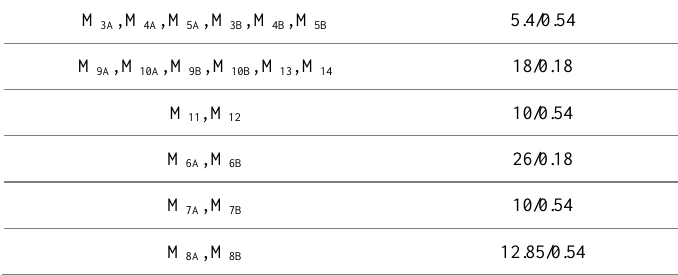
Table 2. Bias Values